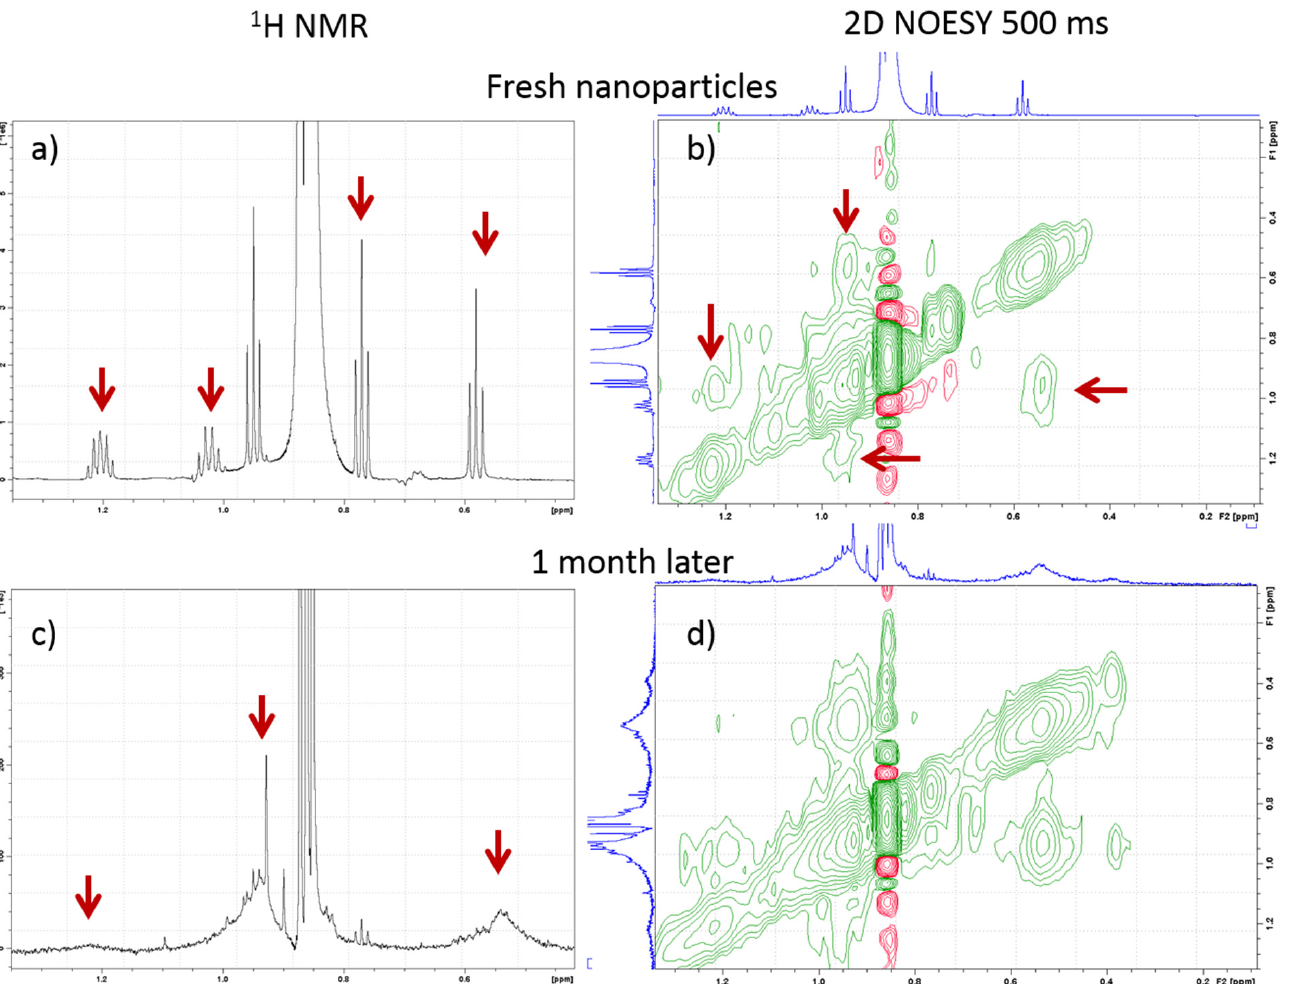
Figure 3. One-dimensional 1 H NMR spectrum of fresh NPs of IIIw showing narrow signals of TBOZ ( a ), between which negative NOE cross peaks are observed in 2D NOESY spectra ( b ). One month later broad signals of residual TBOZ are detected ( c ), which also showed negative NOE cross peaks ( d ).